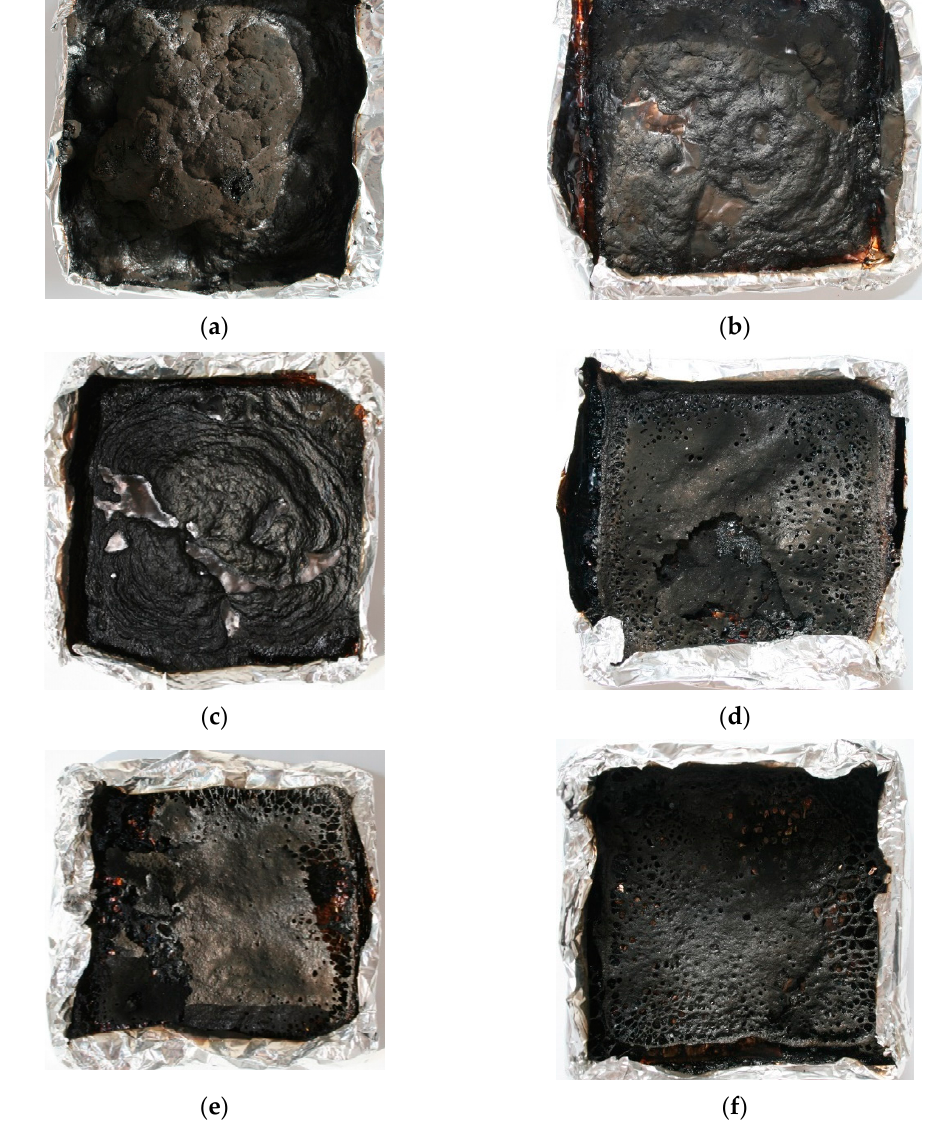
Figure 10. Photographs of the PU/10APP ( a ) PU/20APP ( b ) PU/30APP ( c ) PU/10HGO A ( d ) PU/20HGO A ( e ) and PU/30HGO A ( f ) after cone calorimetry